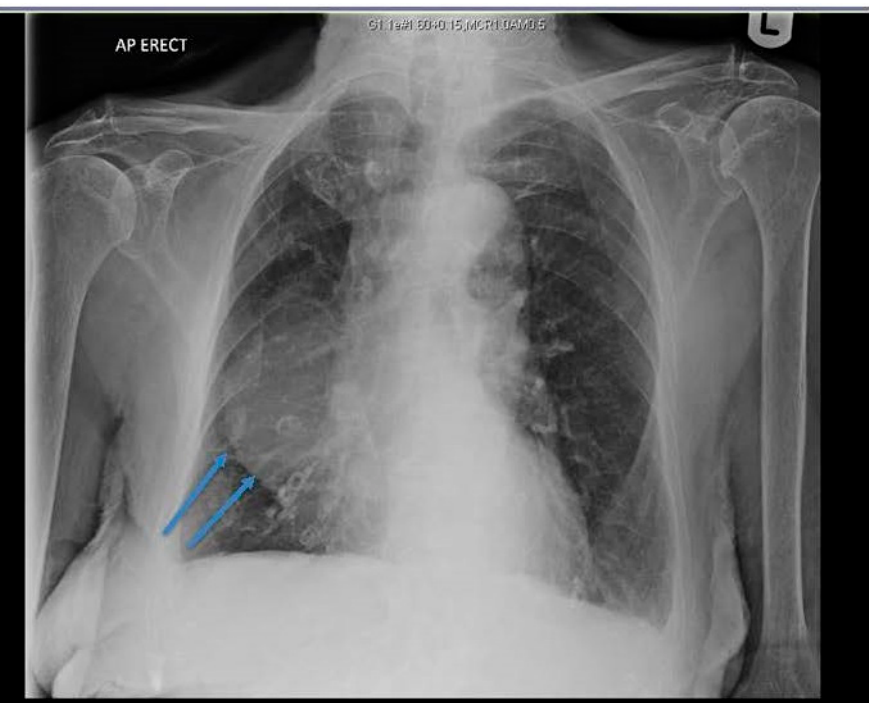
Figure 1. Chest X-ray (CXR) showing right sided soft tissue density, hemispherical in shape, projected over the right middle and lower zones (arrows).